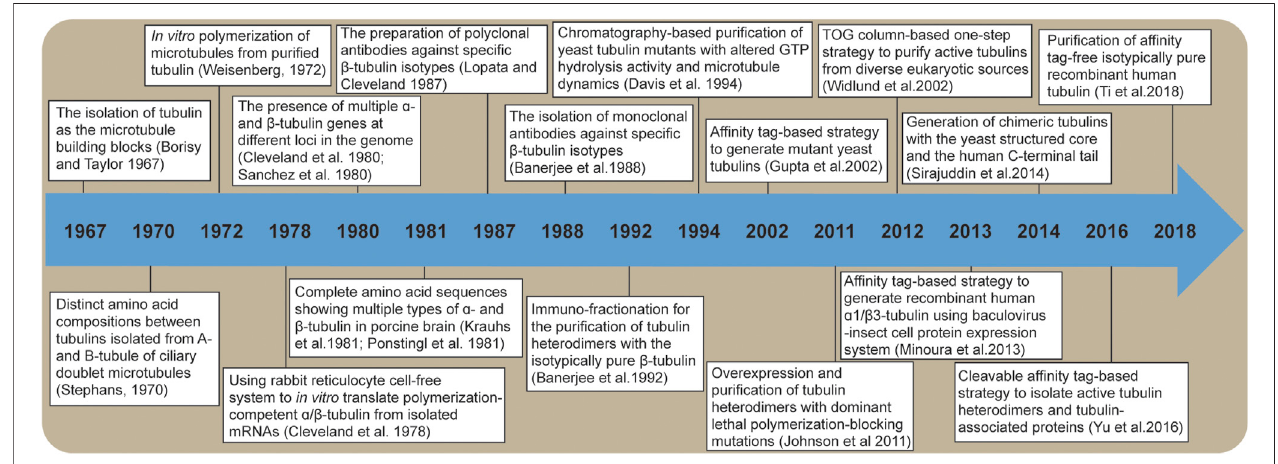
FIGURE 1 | A timeline of major breakthroughs that have advanced our understanding of tubulin